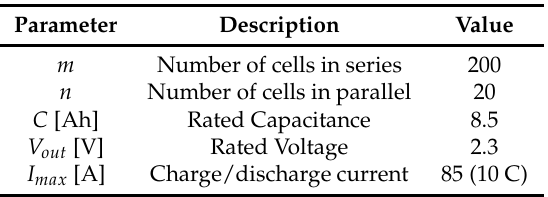
Table 1. Battery parameters.